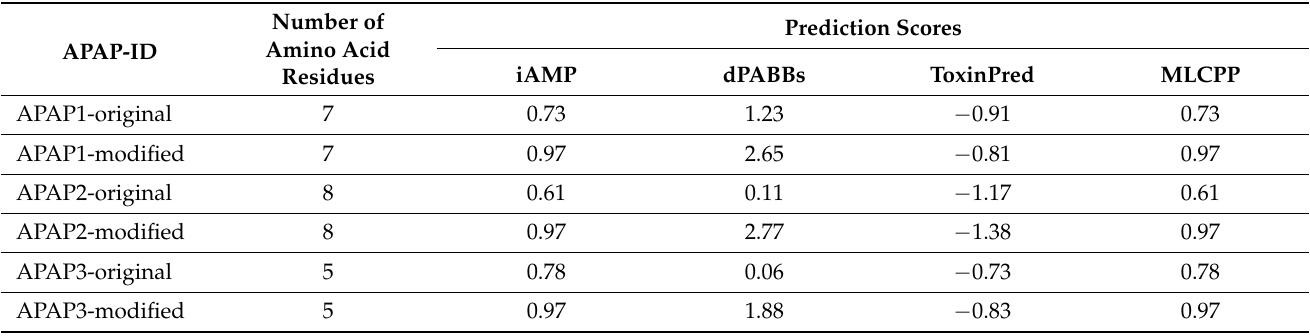
Figure 1. Growth patterns of P. acnes isolates under the clindamycin concentration of 10 µ g/mL after 24, 48, and 72 h. Table 1. Predictive probability score or SVM scores for bioactive peptide prediction